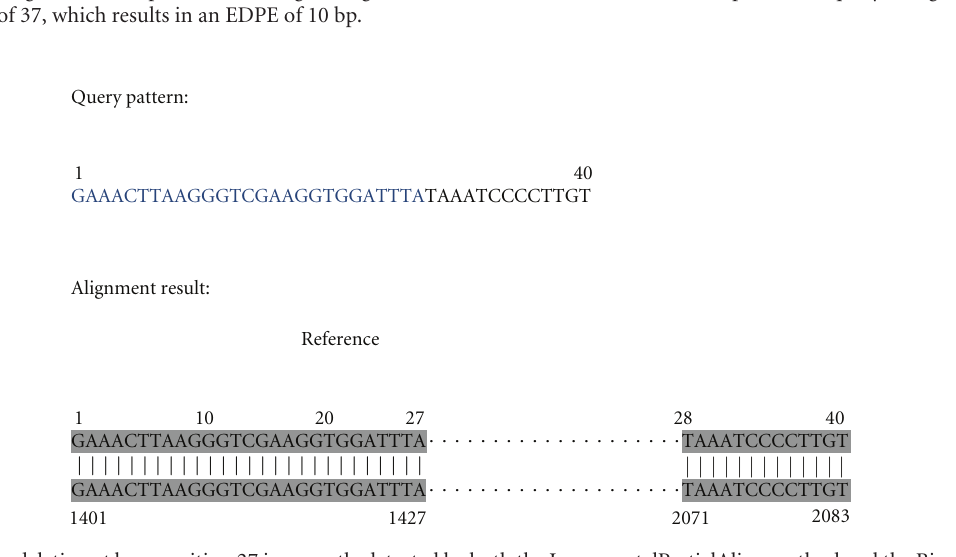
Figure 3: The large deletion at base position 27 is correctly detected by both the IncrementalPartialAlign method and the BinaryPartialAlign